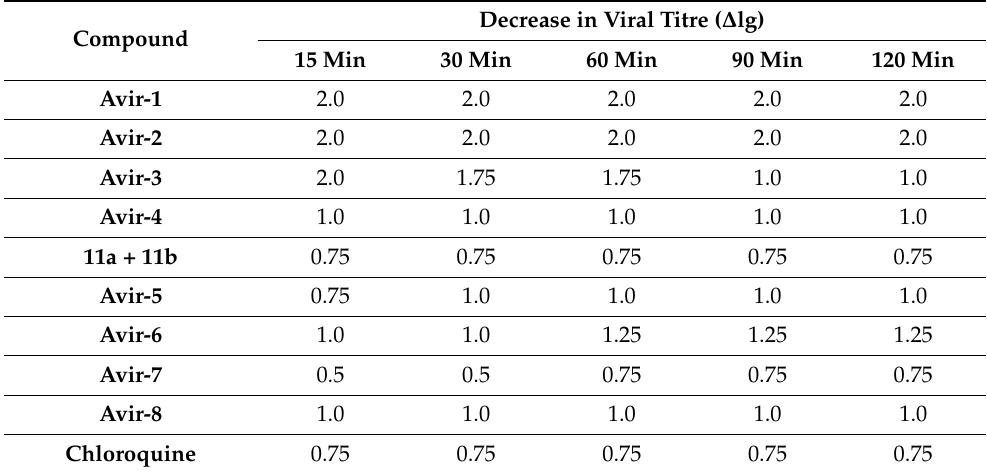
Table 5. Pre-treatment of healthy HCT-8 cells with heterocyclic compounds and subsequent infection with coronavirus (OC-43